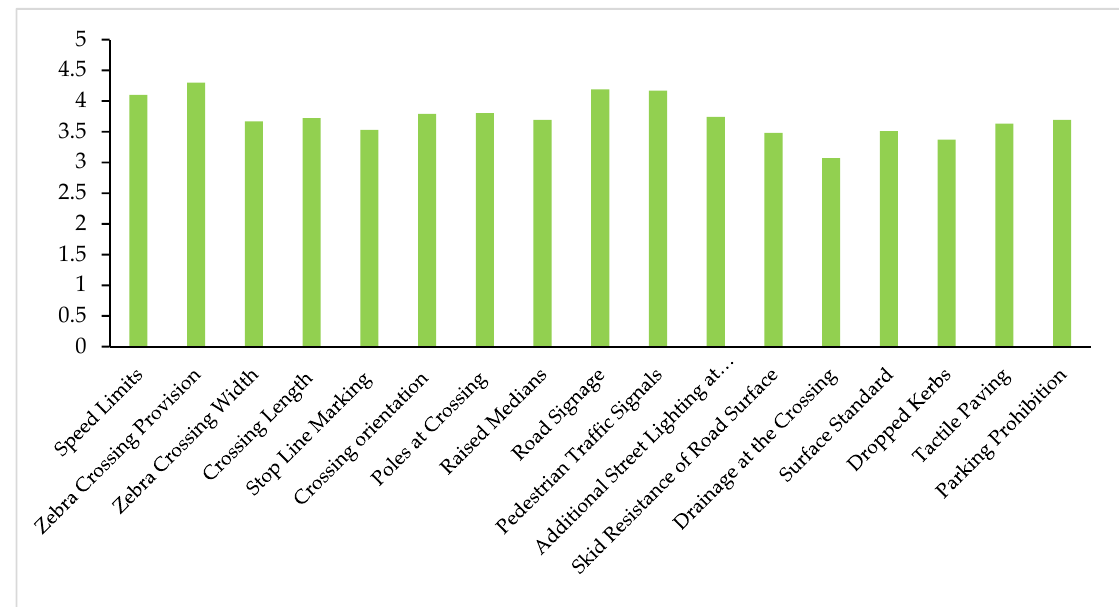
Figure 2. Coefficient of indicators estimated using a questionnaire survey. All coefficients of the pedestrian crossing indicators and Pi were calculated based on Tables 1 and 2. As a result, the PLCOS, PCLOS%, and PLOS grades for the Ministry of Domestic Trade intersection were found (using Equations (1) and (2) and Table 3). Typical results for calculating the crossing LOS are shown below (Equation (3)).